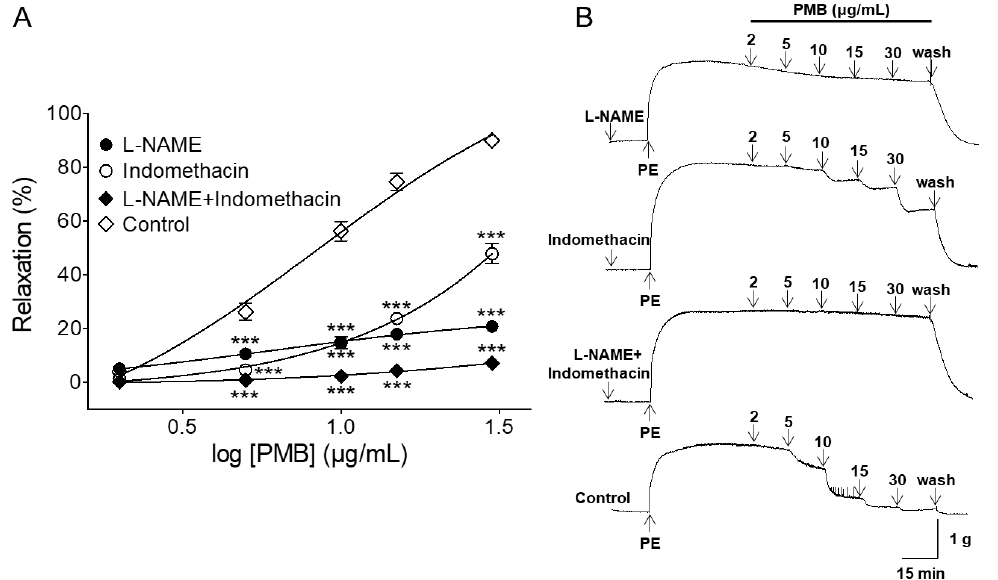
Figure 2. Concentration-dependent relaxation effect of PMB (2–30 μg/mL) on phenylephrine (PE, 1 μM)-pre-contracted endothelium-intact aortic rings in the presence and absence (control) of NG-nitro- l -arginine methyl ester (L-NAME, 100 μM), or indomethacin (10 μM), or a combination of L-NAME ( B ). Values are expressed as mean ± SEM ( n = 6). *** p < 0.001 vs. control.